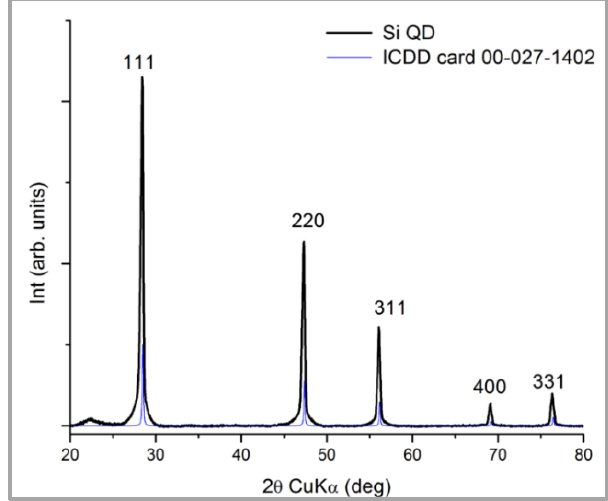
Figure 2. X-ray diffraction (XRD)pattern performed on the synthesized quantum dots (QDs).